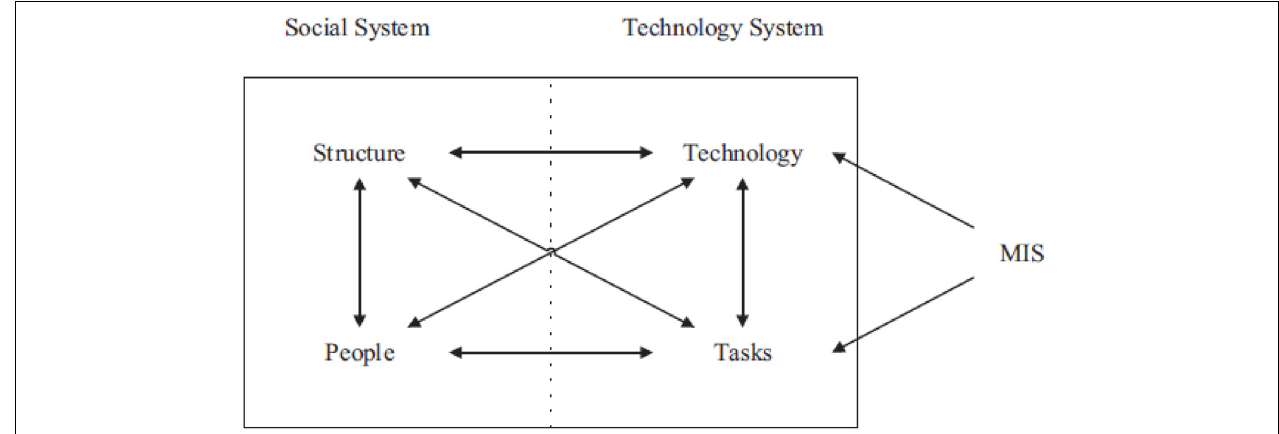
FIGURE 1 | Social-technical theory (Bostrom and Heinen,